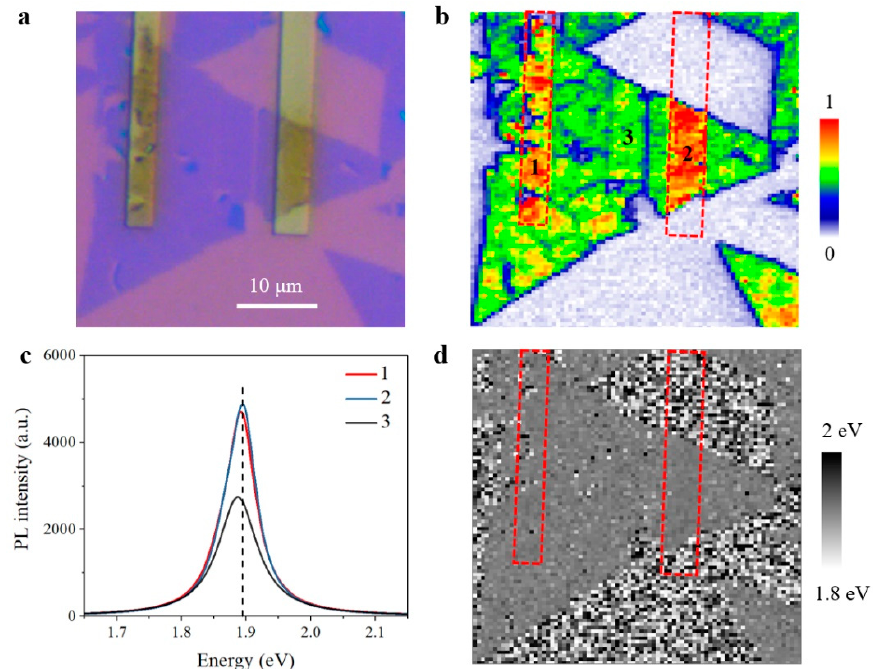
Figure 9. PL mapping of suspended monolayer MoS 2 . ( a ) Optical image. Yellow regions: etched trench. ( b ) Normalized PL mapping result of ( a ). Red dashed boxes: etched trench in ( a ). ( c ) PL spectra of regions marked in ( b ). ( d ) Emission peaks of PL intensity maximum in (b).